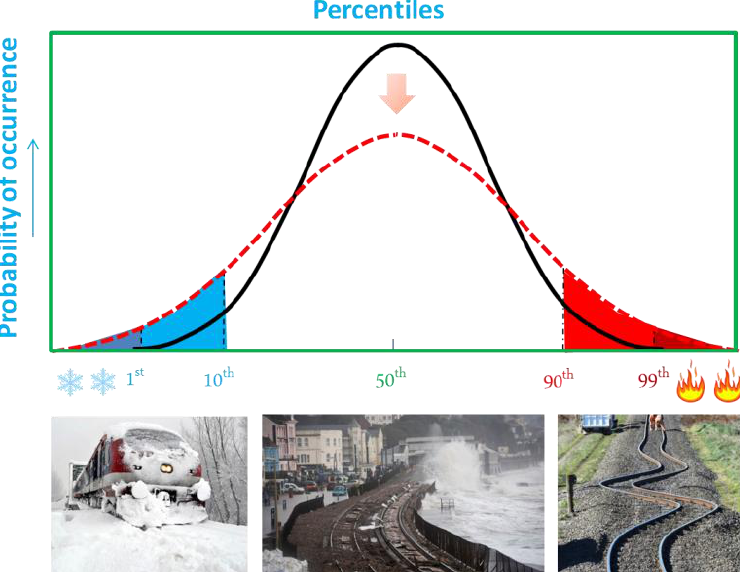
Figure 1. The threshold of extreme event percentiles and potential impacts.